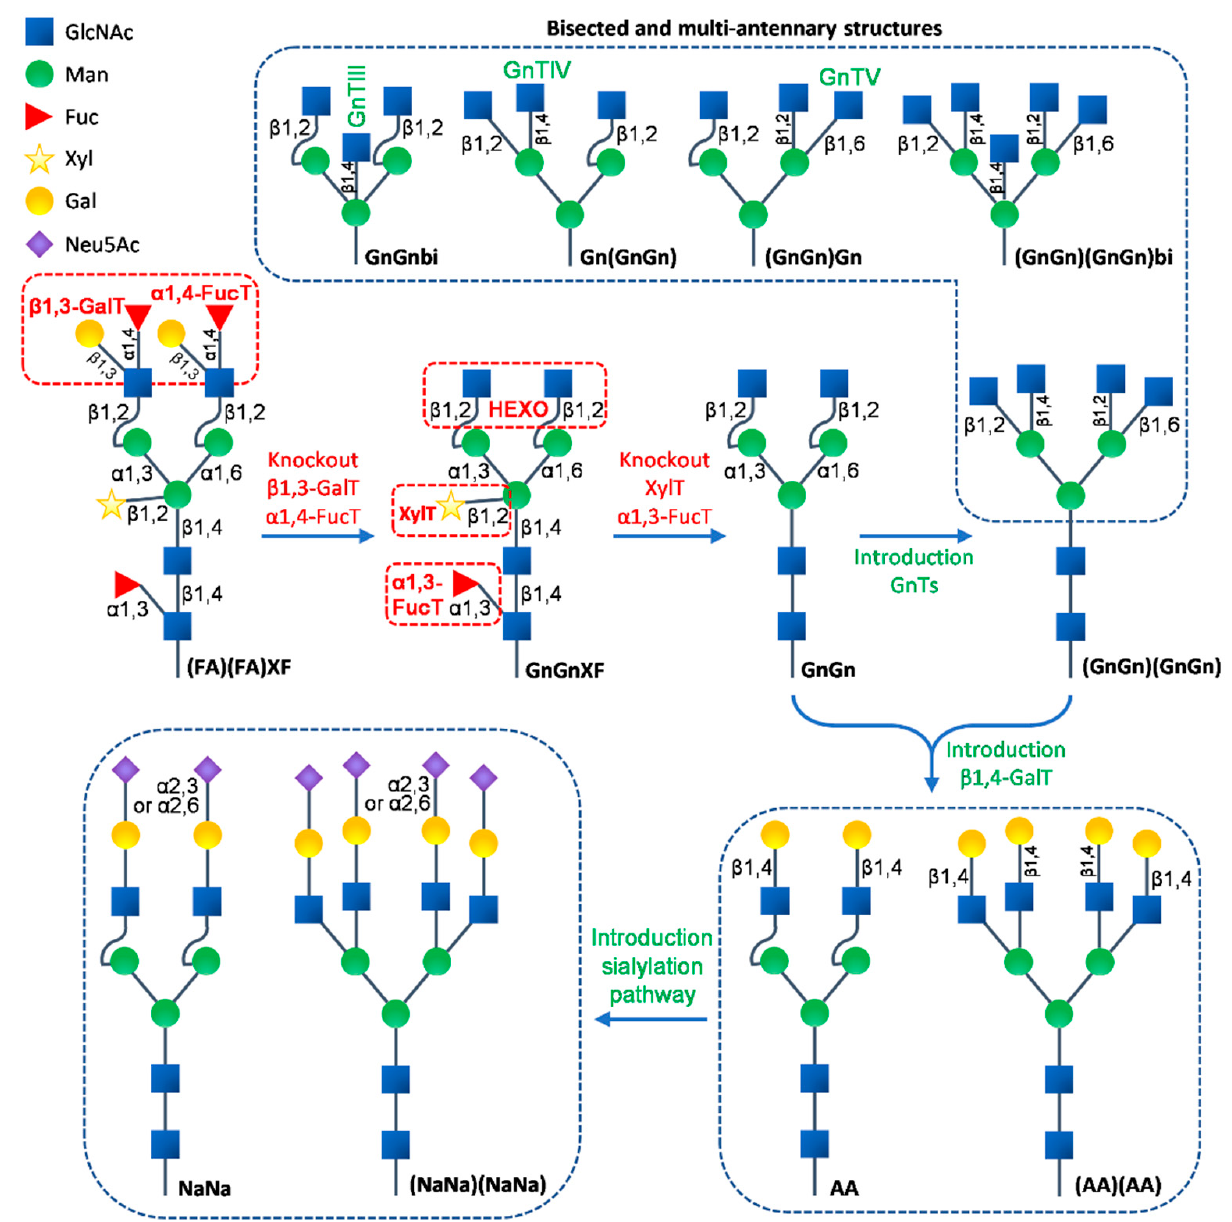
Figure 2. Glycoengineering of plants for the production of human-type complex N -glycan struc- tures. To eliminate plant-specific α 1,3-linked fucose and β 1,2-linked xylose residues, two enzymes, β 1,2-xylosyltransferase (XylT) and core α 1,3-fucosyltransferase ( α 1,3-FucT), have been knocked down/out, generating the common eukaryotic core GnGn. Furthermore, a more homogenous GnGn can be achieved by the elimination of β 1,3-galactosyltransferase ( β 1,3-GalT) and α 1,4-FucT, the enzymes responsible for the generation of Le a epitopes, in addition to the knockout of two β - N -acetylhexosaminidases (HEXO), which catalyze the trimming of the terminal GlcNAc residues, to prevent the formation of the paucimannosidic structures. Various bisected and multi-antennary structures can be generated by introducing the N -acetylglucosaminyltransferases (GnTs) that are absent in plants (i.e., GnTIII-GnTV). The elaborate introduction of β 1,4-GalT and enzymes involved in the human sialylation pathway results in β 1,4-galactosylation followed by terminal sialylation (via α 2,3- or α 2,6-linkage) to GnGn or multi-antennary structures, such as (GnGn)(GnGn), generating fully sialylated human-type N -glycans. Neu5Ac, N -acetylneuraminic